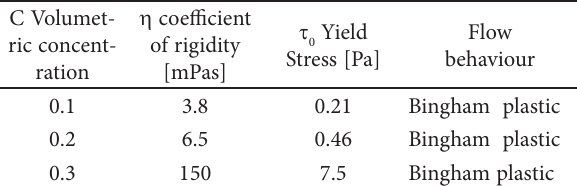
Table 13. Flow properties of fly ash, Dorog hazardous waste